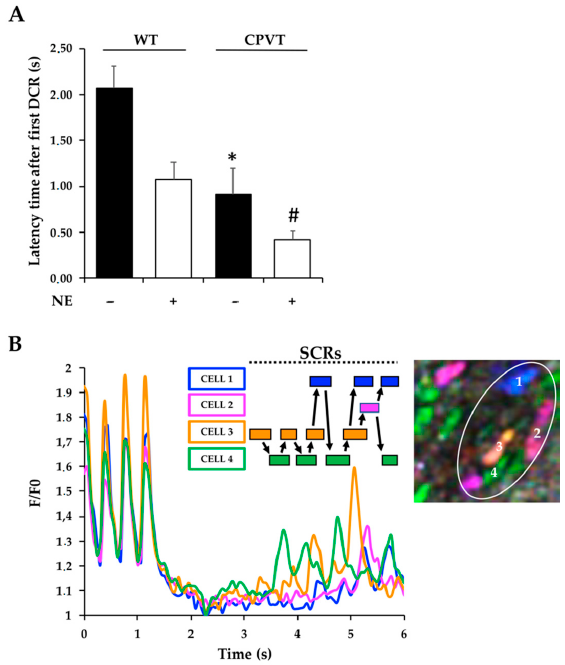
Figure 5. Diastolic SCR synchronization in myocardial cell clusters. ( A ) Cells in CPVT slices showed significantly shorter latency, compared to controls (WT), between the first SCR upon pacing inter- ruption and the subsequent ones in neighboring CMs. Error bars represent SD (* p < 0.05 compared to WT in basal condition; # p < 0.01 compared to CPVT upon NE stimulation). ( B ) Representative traces of Ca 2+ dynamics in a CPVT slice that underwent a pace-stop protocol. The colored traces show intracellular Ca 2+ changes in the cells identified by the same color in the regions of interest (ROIs) delineated in the corresponding image on the right side of the panel. The rectangles above the chart highlight, in the same color coding, the duration of spontaneous Ca 2+ elevations, defined as increase of the fluorescence signal higher than two SDs of the basal fluorescence intensity. Arrows connect the individual boxes, each one representing a single cell in the field, showing the intercel- lular transmission of temporally overlapped SCRs in adjacent cells, which underscores the influence SCR may have on further SCRs. In the representative example shown, the initiating event occurs in cell #3 (orange line and box) and is subsequently transmitted to the others.